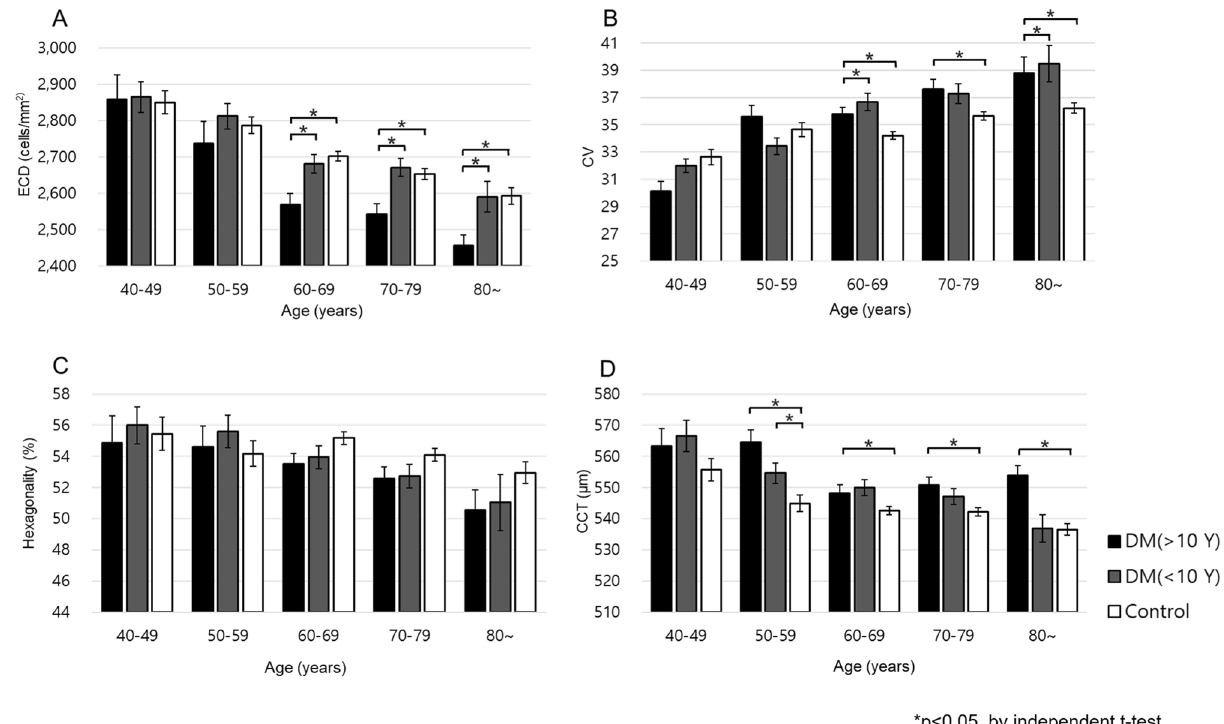
Figure 3. Comparisons of the mean values of ECD ( A ), CV ( B ), hexagonality ( C ) and CCT ( D ) of the diabetic groups based on diabetic duration across the age groups. ECD Endothelial cell density, CV Coefficient of variation, CCT Central corneal